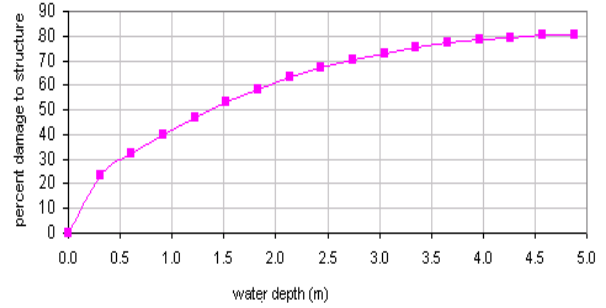
Fig. 1. Example of damage curves as function of the flow depth (US Army Corps of Engineers, 2000).